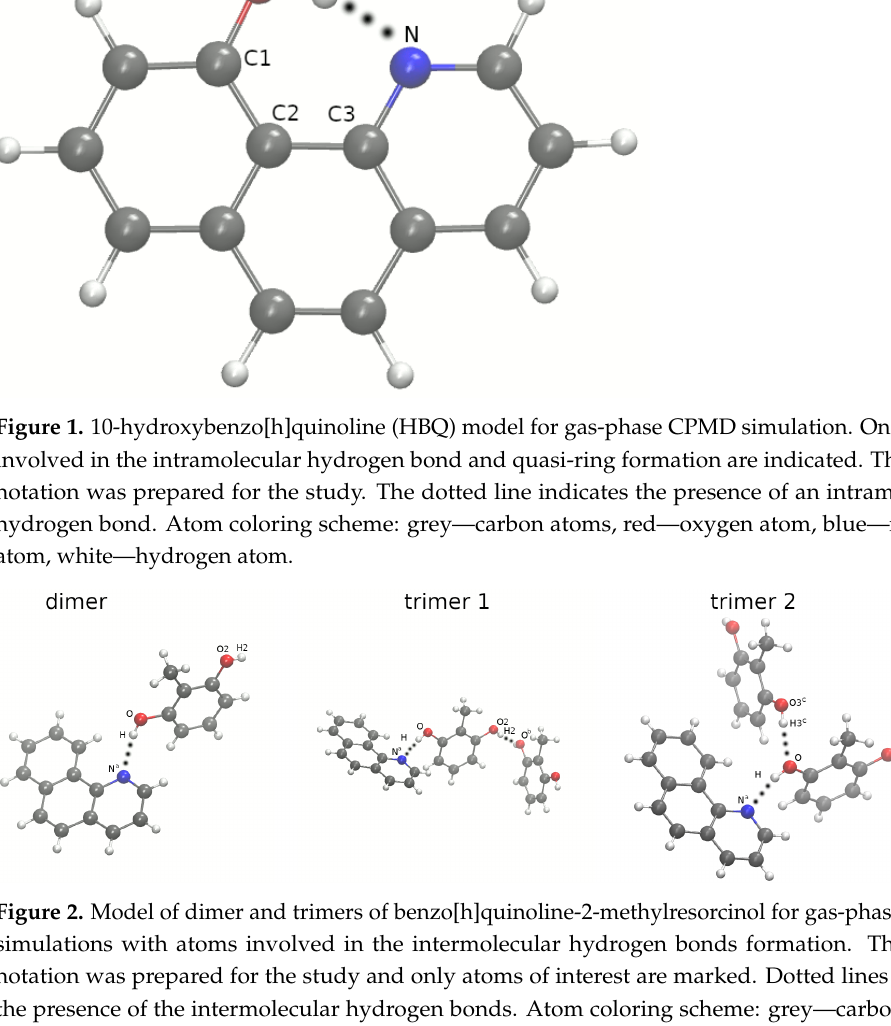
− y, 1 +x, 1 +z) for the trimer 1, 2 2 2